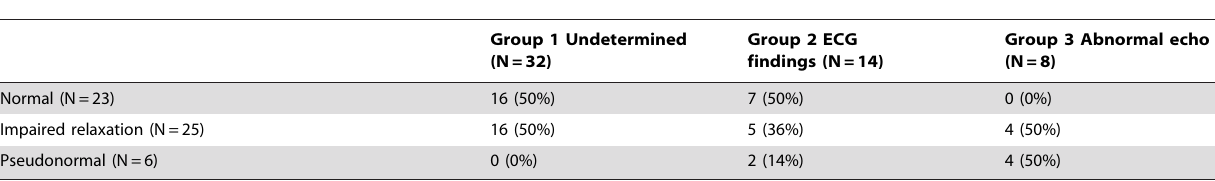
Table 3. Diastolic function in patients with undetermined and cardiac forms of Chagas disease.